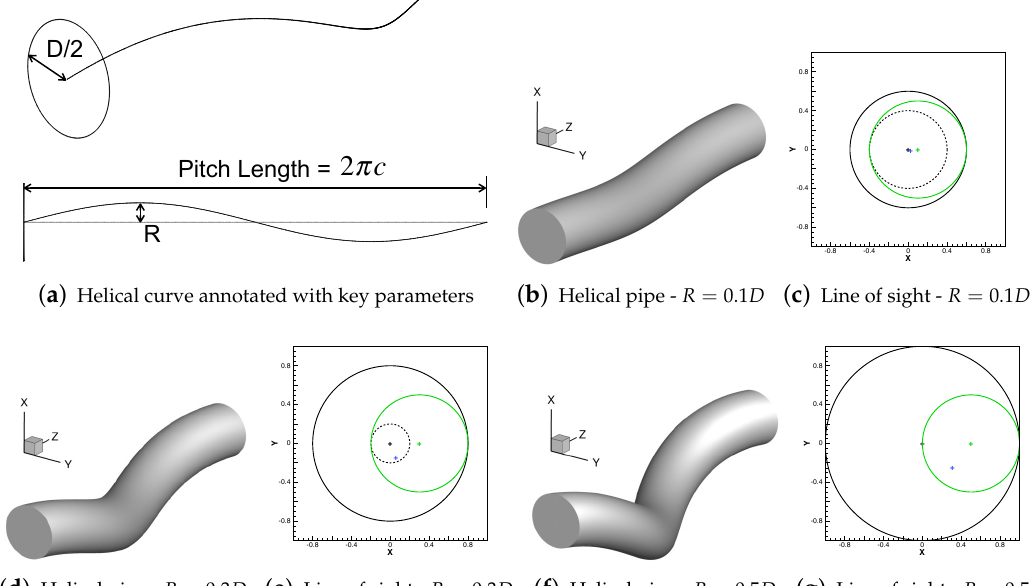
Figure 2. The helical geometries studied here have a small amplitude, R , relative to the pitch length. In ( c , e , g ) the green circle indicates the pipe boundary and the larger black circle indicates the bounding cylinder of the pipe. The dashed circle represents the axial line-of-sight that can exist for small amplitude helical pipes—note that this line-of-sight just disappears when R = 0.5 D , as seen in ( g